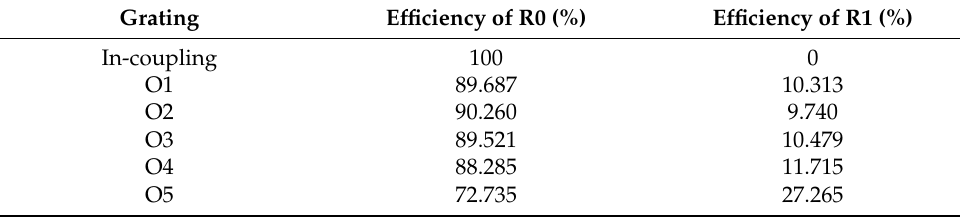
Table 3. Normalized efficiencies of